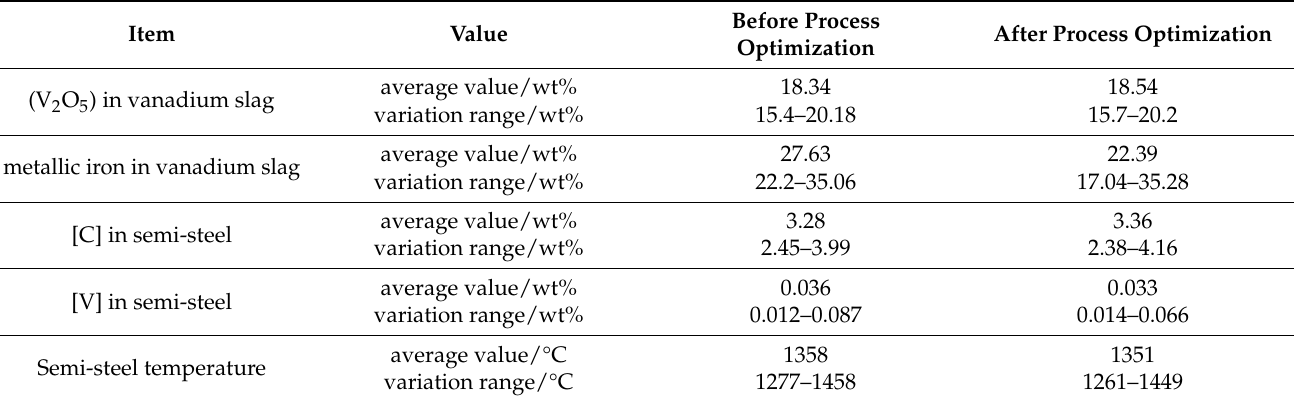
After process optimization, the average vanadium oxide content of vanadium slag increased by 0.2 wt%. Under the condition that the vanadium content of hot metal was 0.33%, after the process optimization, the metal iron content of vanadium slag was signifi- cantly reduced, from an average of 27.64 wt% to 22.39 wt%. When the carbon content in the hot metal was 4.04 wt% and the oxygen consumption was 850 Nm 3 /heat, the